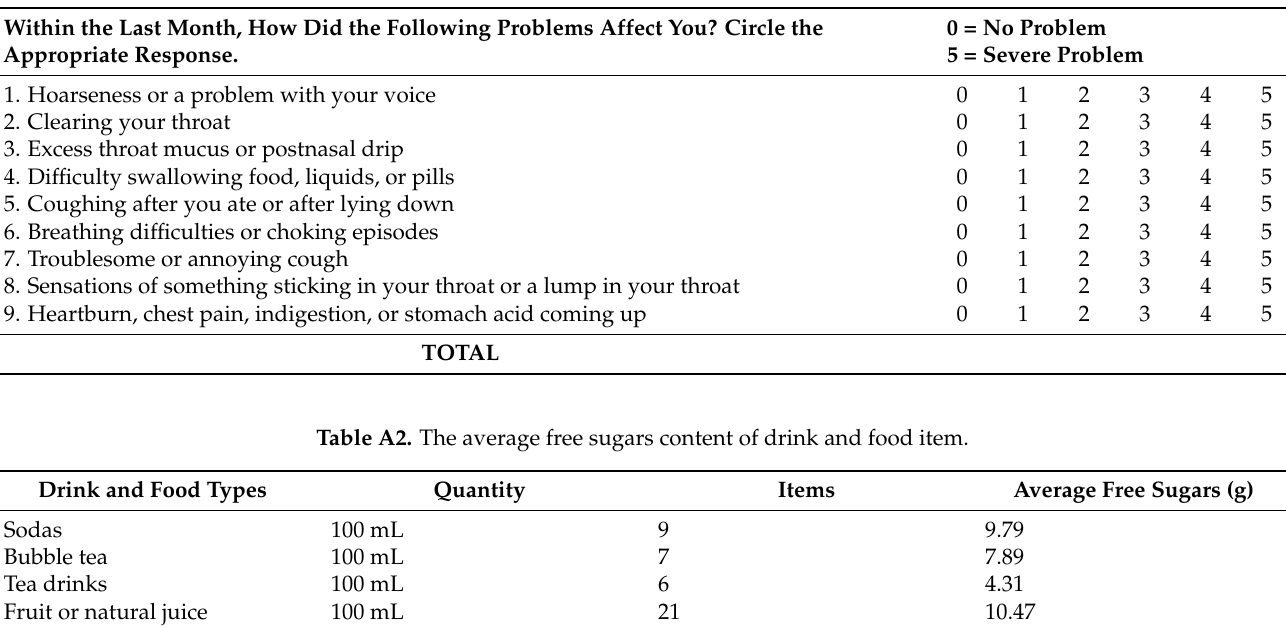
Table A1. The Reflux Symptom Index (RSI).